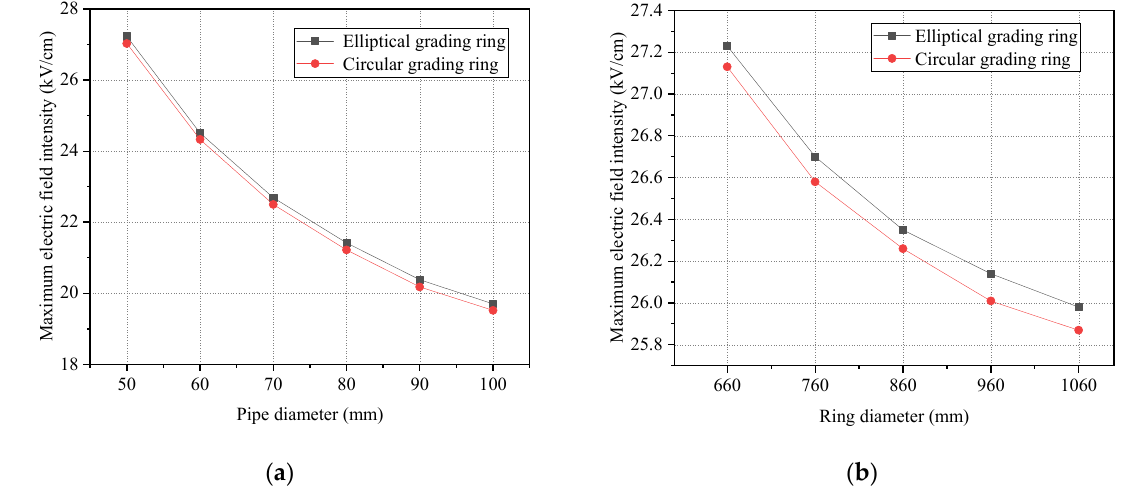
Figure 8. MEI of elliptic and circular grading rings (shielding rings) with different pipe diameters and ring diameters. ( a ) MEI on the grading ring surface with different pipe diameters; ( b ) MEI on the grading ring surface with different ring diameters.